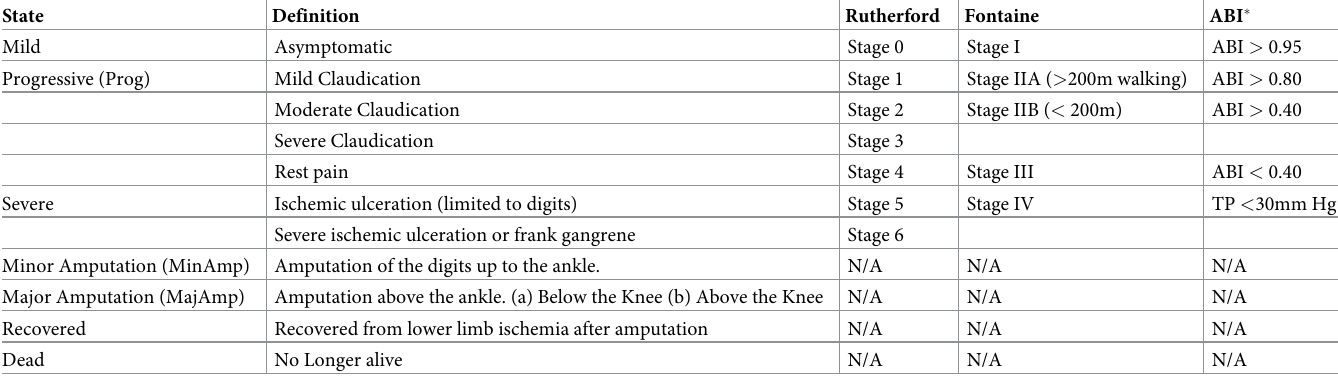
Table 2. State classification of lower limb PAD